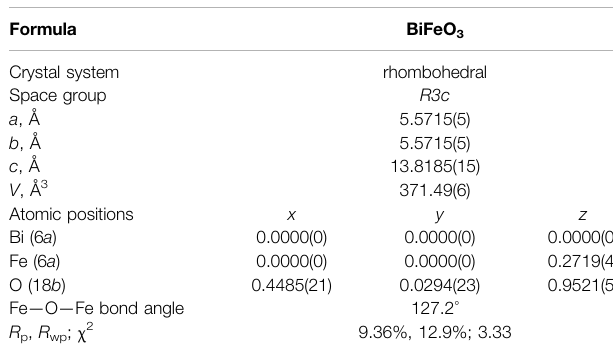
TABLE 1 | Crystal structure parameters ( a , b , c , V ), atomic positions ( x , y , z ), and the tilting angle of FeO 6 octahedra derived from the Rietveld analysis of XRD data of the as-prepared BiFeO 3 . R p , R wp and χ 2 are goodness parameters of the fi